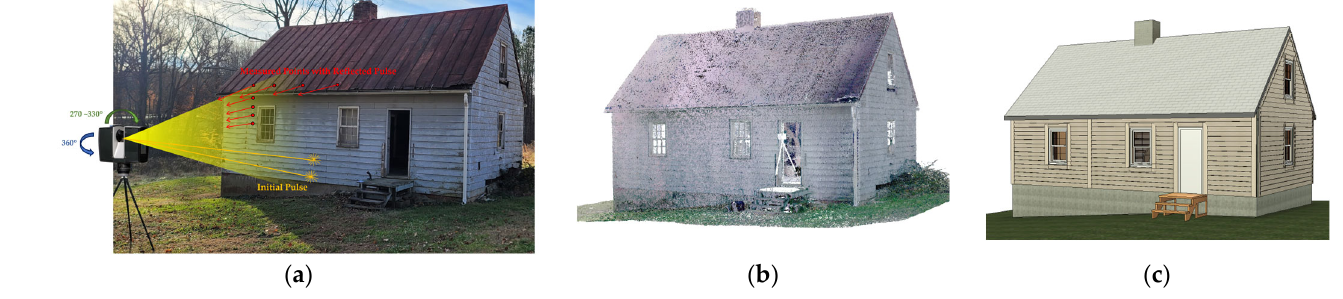
Figure 3. TLS and its application in HBIM: ( a ) principle of LiDAR technology (inspired by [51]); ( b ) a resultant point cloud of TLS survey; ( c ) an HBIM model developed from TLS point cloud.